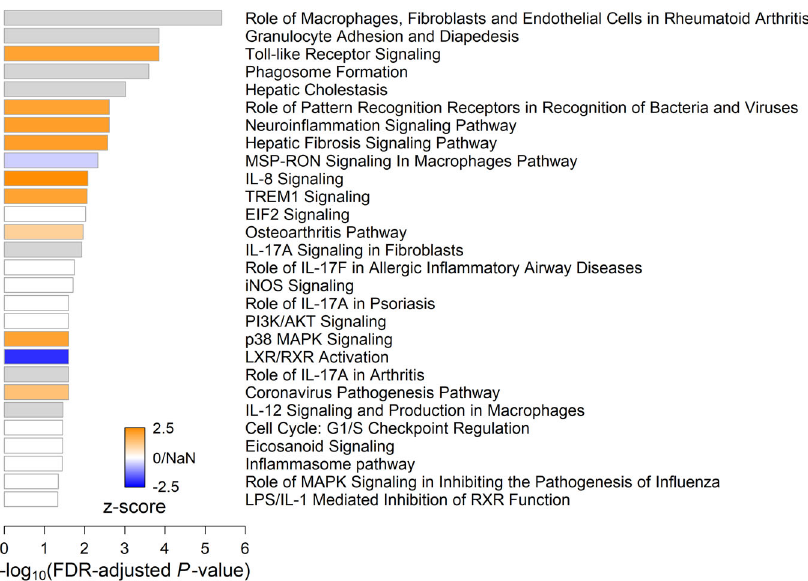
Fig. 4 IPA Canonical Pathways analysis on common leading-edge genes from gene sets that showed directionally consistent, signi fi cant GSEA enrichment scores across trials. Bar width indicates the strength of an IPA Canonical Pathway ’ s enrichment for the leading-edge genes. Bar color indicates the IPA z-score, which is the degree to which the pathway is activated (orange) or inactivated (blue) based on mean log 2 fold-changes in transcript abundance between protected and non-protected subjects for leading-edge genes found in the pathway. White bars indicate an ambiguous activation state ( z = 0) or pathways ineligible for activation analysis because the overlap between common leading-edge genes and pathway participants used to compute the z -score was less than four ( z -score = NaN). Gray bars indicate that there is insuf fi cient evidence in the IPA Knowledge Base to con fi dently predict an activation state for the